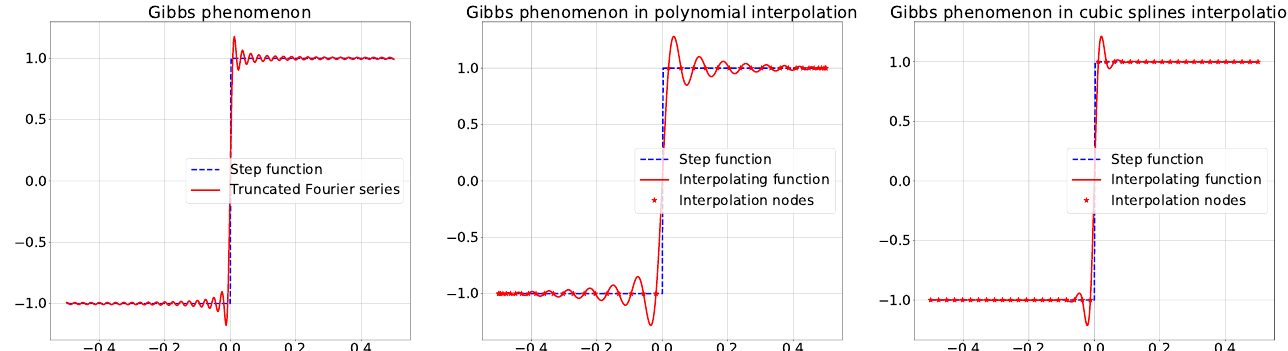
Figure 1. From left to right: Truncated Fourier series, polynomial interpolation (on Chebyshev–Lobatto nodes) and cubic splines interpolation (on equispaced nodes) of the Heaviside step function.